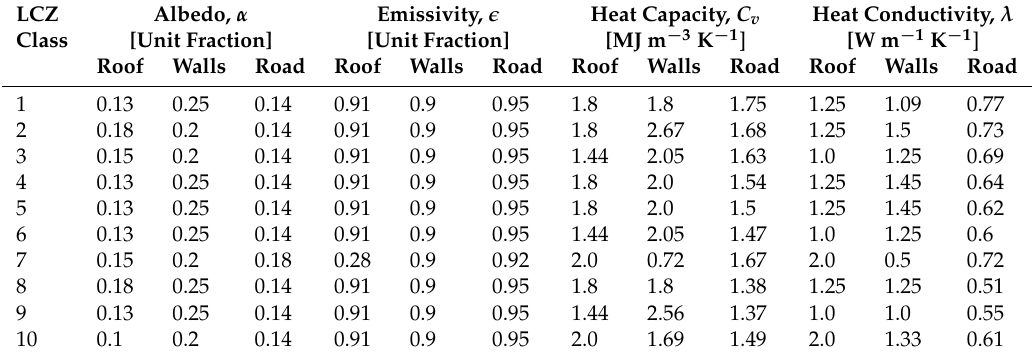
Table A3. Radiative and thermal urban canopy parameters per LCZ class, compiled from Stewart and Oke [23] and Stewart et al. [65]. The latter paper only provides thermal admittance values per LCZ class, yet their underlying facet heat conductivity and capacity values are provided by Scott Krayenhoff (pers. communication) and are reported